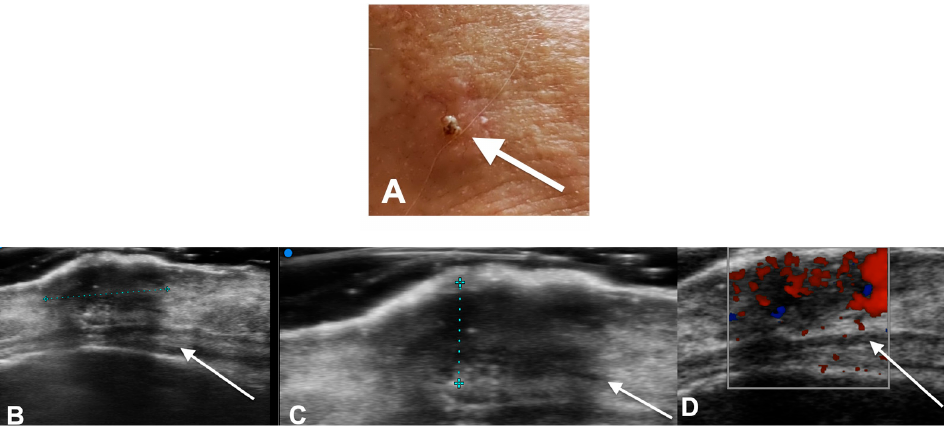
Figure 1. ( A ) A 73-year-old male patient. Right frontal diffuse infiltrative squamous cell carcinoma 444 two slightly hyperchromic hard and hypomobile areas to the underlying floors. ( B – D ) HF Ultra- 445 sound examination performed with a very high frequency probe (48 Mhz). ( B ) Right upper frontal 446 site hypoechoic area of the hypodermis with blurred margins lower. ( C ) Non-encapsu- lated of the 447 following dimensions: Dt 6.9 mm × DL2.4 mm. ( D ) The lesion shows intralesional micro-vasculature 448 on Color Doppler control.